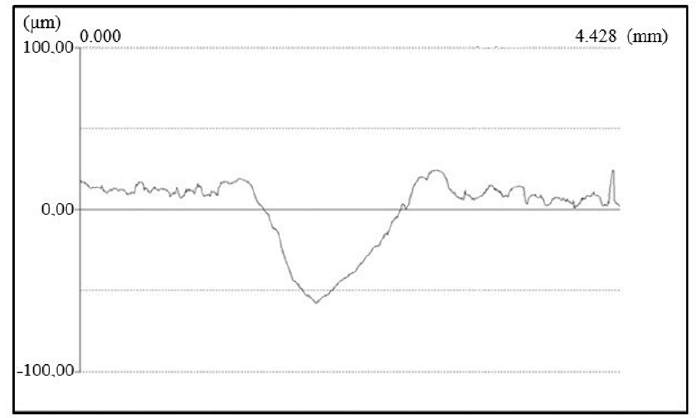
Figure 13. Tribological track profile on Sample 2 after the test at 400 °C.